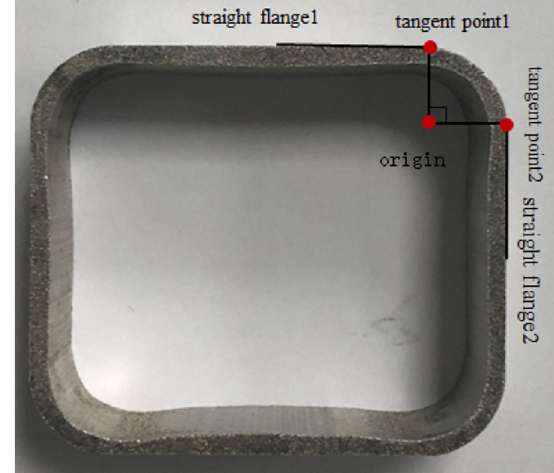
Figure 13 Fillet measurement mode